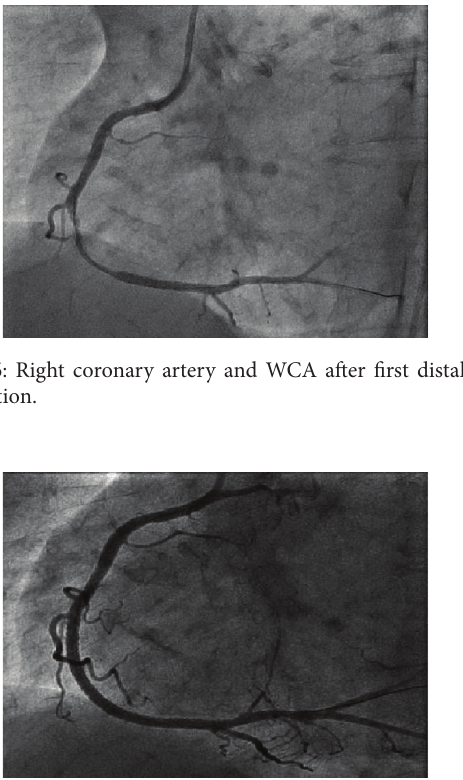
Figure 2: Woven coronary artery anomaly at the midsegment of the right coronary artery.